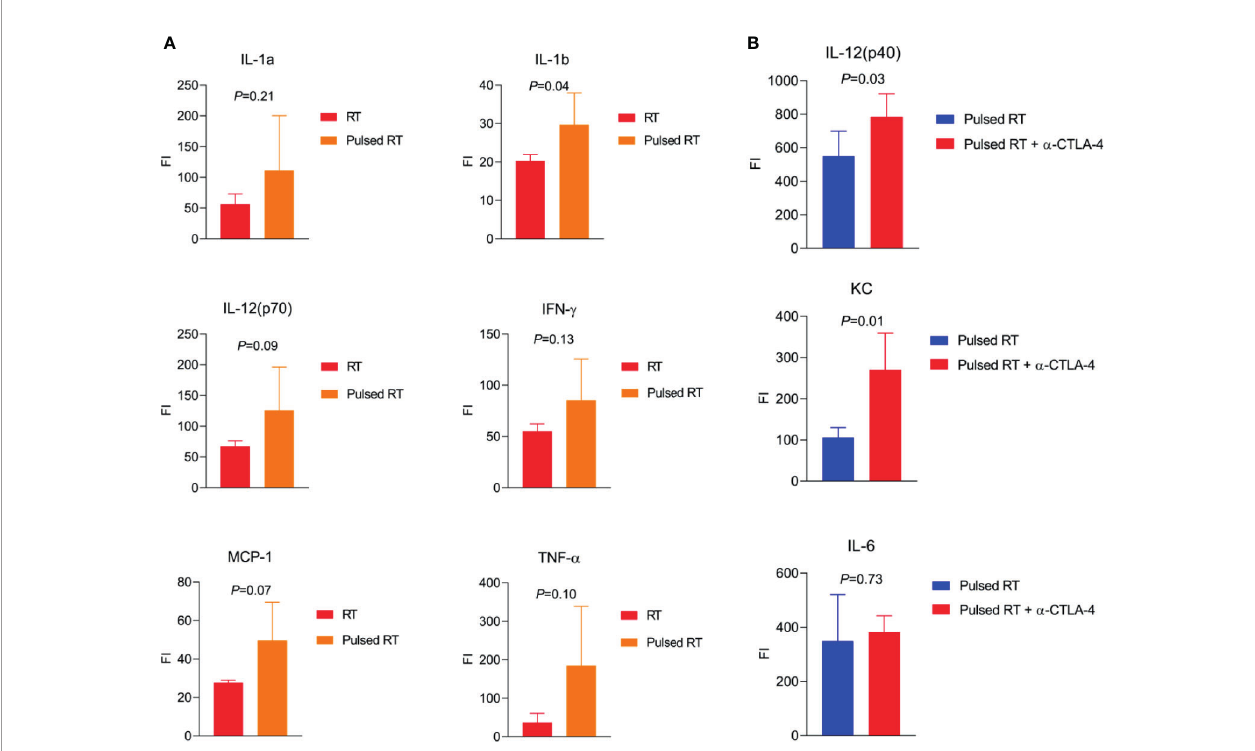
FIGURE 1 | Effector cytokines produced by pulsed-RT, bridging innate and adaptive immunity. (A, B) The right hind legs of 129Sv/Ev mice were subcutaneously implanted with 2.5×10 5 344SQ-P cells to establish primary tumors, while the left legs were concurrently implanted with 1×10 5 cells on day 0 to establish secondary tumors. Primary tumors were irradiated with 12Gy×2 on days 9 and 10, while secondary tumors were irradiated on days 15 and 16 post-tumor inoculation for the pulsed-RT group. Where applicable anti-CTLA4 was given i.p. on days 6 and 12. Sera were collected on day 19 (n=5 mice/group) and subjected to multiplex cytokine/chemokine analysis. Plates were read with Luminex platform and values were compared using Student ’ s